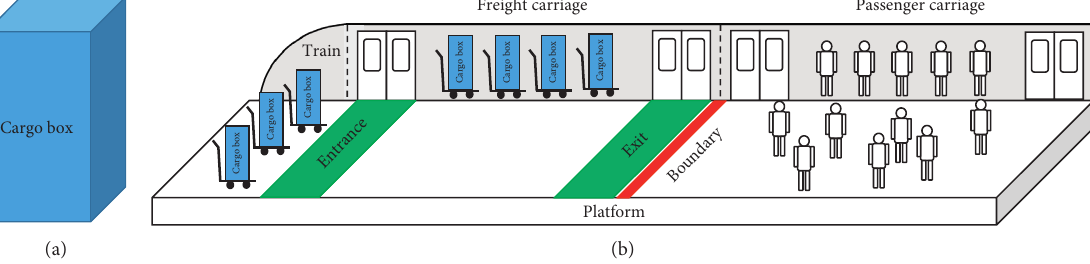
Figure 1: Schematic diagram of cargo